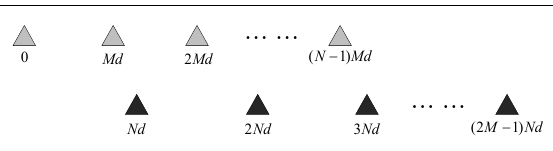
Figure 1. Illustration of the coprime array.